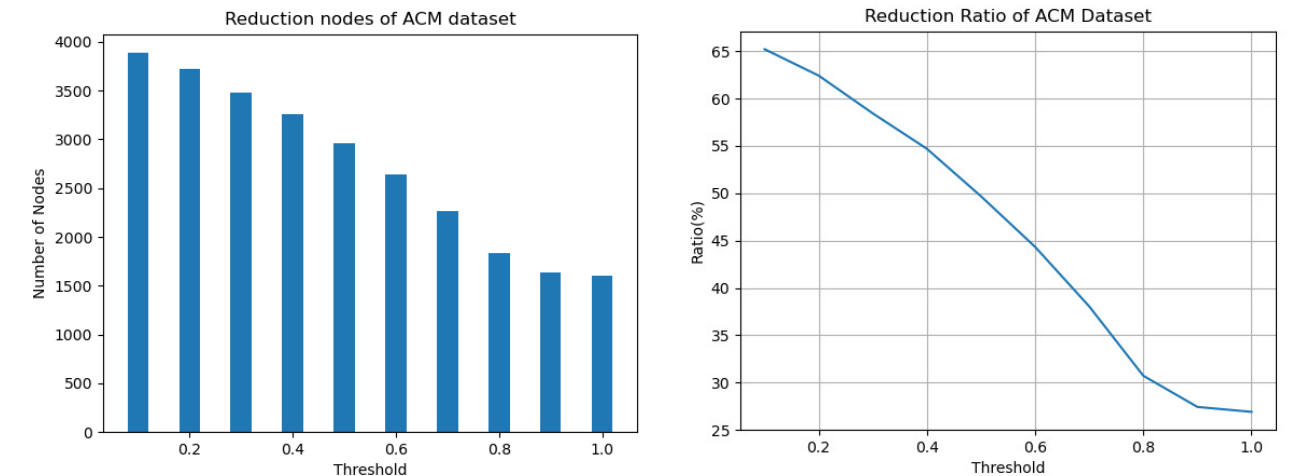
Figure 4. Histogram of the number of nodes reduced by trace equivalence ( Left ) and trend of the ratio of reduced nodes to total nodes ( Right ) on ACM dataset.